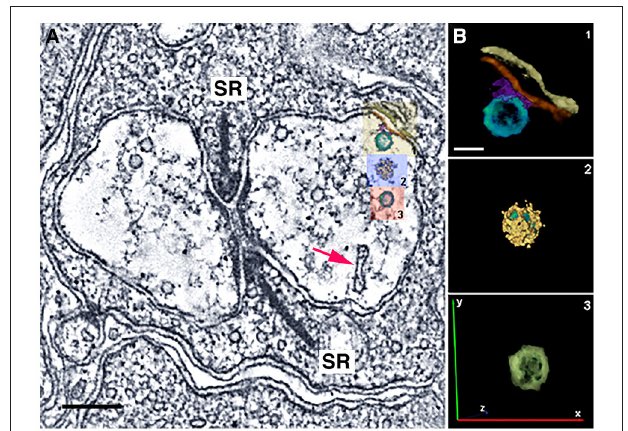
FIGURE 13 | Horizontal cell endings contain different vesicle types. (A) A rod photoreceptor spherule with a horizontal cell axonal terminal with serial reconstructions of selected vesicles in mouse. Small vesicles with a conventional appearance are distributed throughout the terminal. A red arrow points to an endosome. In the right-side horizontal cell terminal, there is a small vesicle tethered to the plasma membrane (yellow box, B1 ). (B) Reconstructions of vesicles: (B1) , A small vesicle (yellow box in A , turquoise vesicle) that is likely attached to the horizontal cell plasma membrane (red) via synaptic proteins (purple). Other structures include the horizontal cell plasma membrane (red) and the rod plasma membrane (yellow-brown). (B2) : A clathrin-coated vesicle (blue box in A ) in the cytoplasm. Clathrin cage (yellow); vesicle (green). (B3) : A small vesicle (red box in A , green) in the cytoplasm. (A) z-section (orthoslice) of a tomogram; (B) Reconstructions of 3 vesicles. Scale bar, 200nm in A , 40nm in B . (Modified from Zampighi et al.,